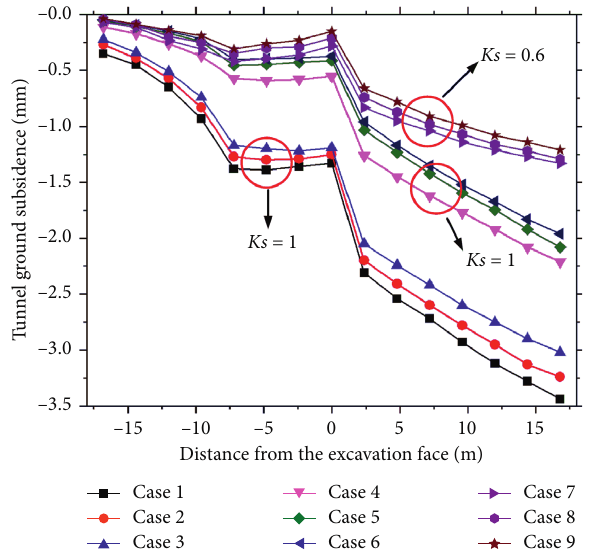
Figure 13: Settlement variation of surface measuring point E under different working